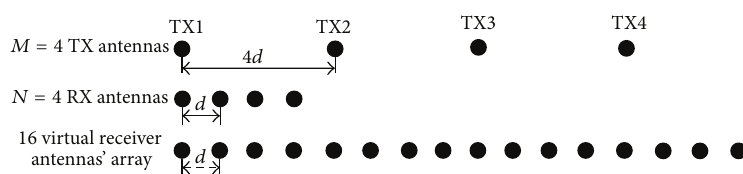
Figure 1: MIMO radar system with 𝑀 = 4 transmitters and 𝑁 = 4 receiver antennas and its virtual array consists of 16 antennas.